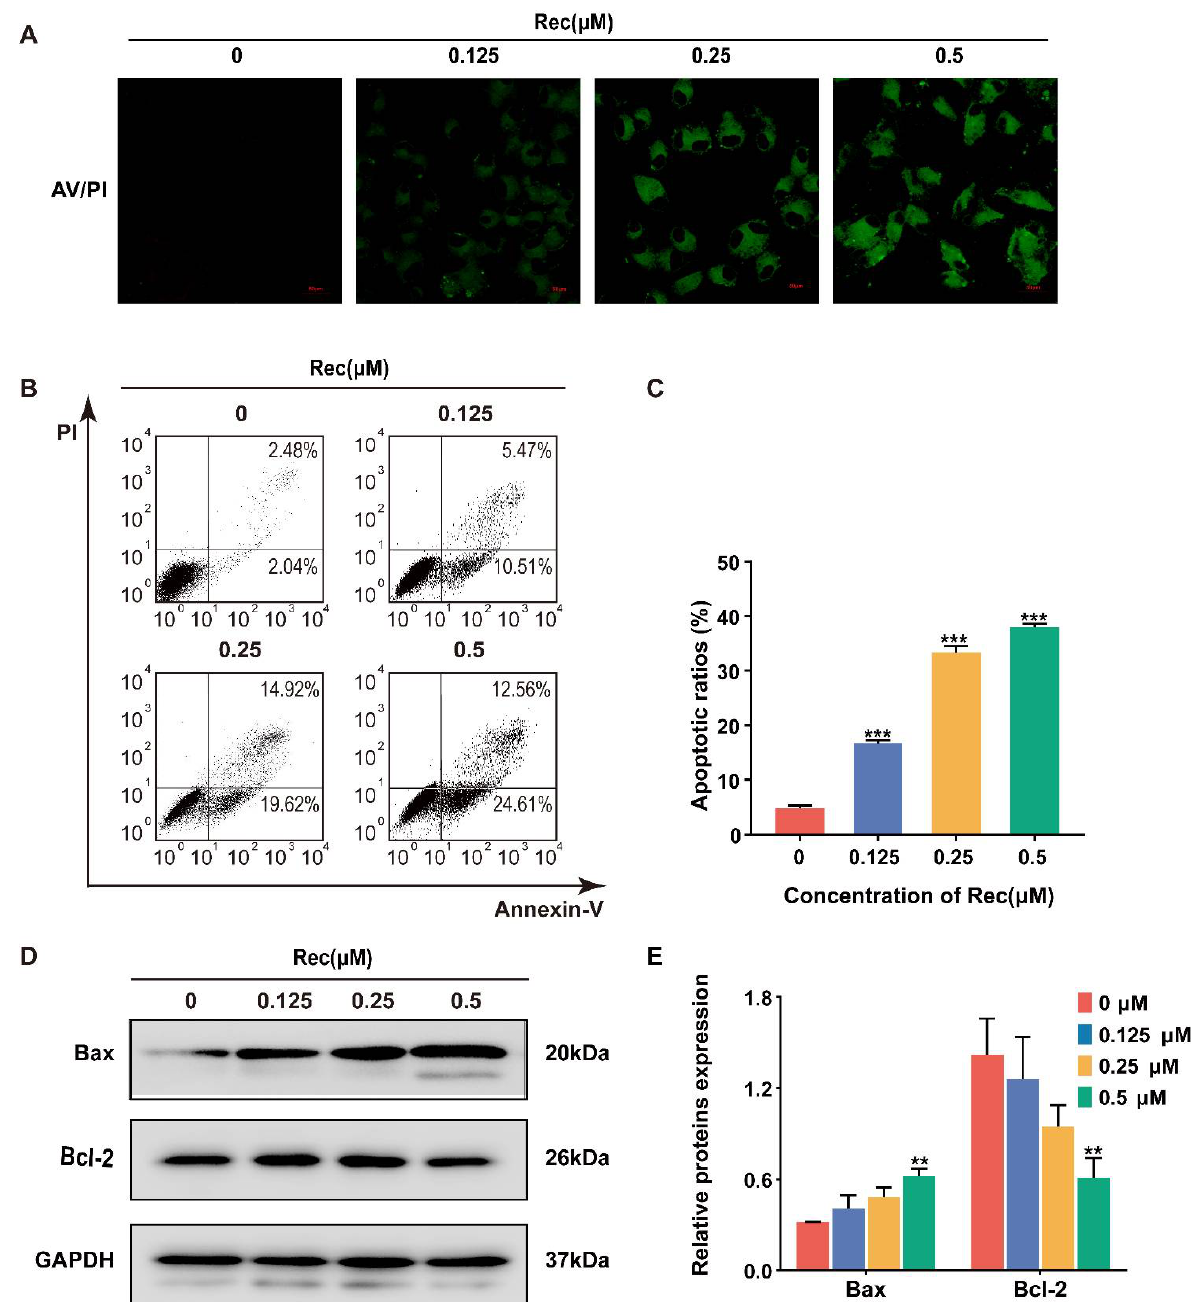
Figure 2. Resistomycin induced apoptosis in HepG2 cells. ( A ) The results of Annexin V/PI staining after HepG2 cells were treated with different concentrations of resistomycin in 24 h. Green fluorescence represents apoptotic cells. Scale bar: 20 μm. ( B , C ) Number and percentage of apoptotic cells measured by flow cytometry with 0, 0.125, 0.25 and 0.5 μM resistomycin for 24 h. ( D , E ) Western blot analysis showing decreased pro-apoptotic protein Bax and increased anti-apoptotic protein Bcl-2. ** p < 0.01 and *** p < 0.001 versus 0 μM resistomycin.